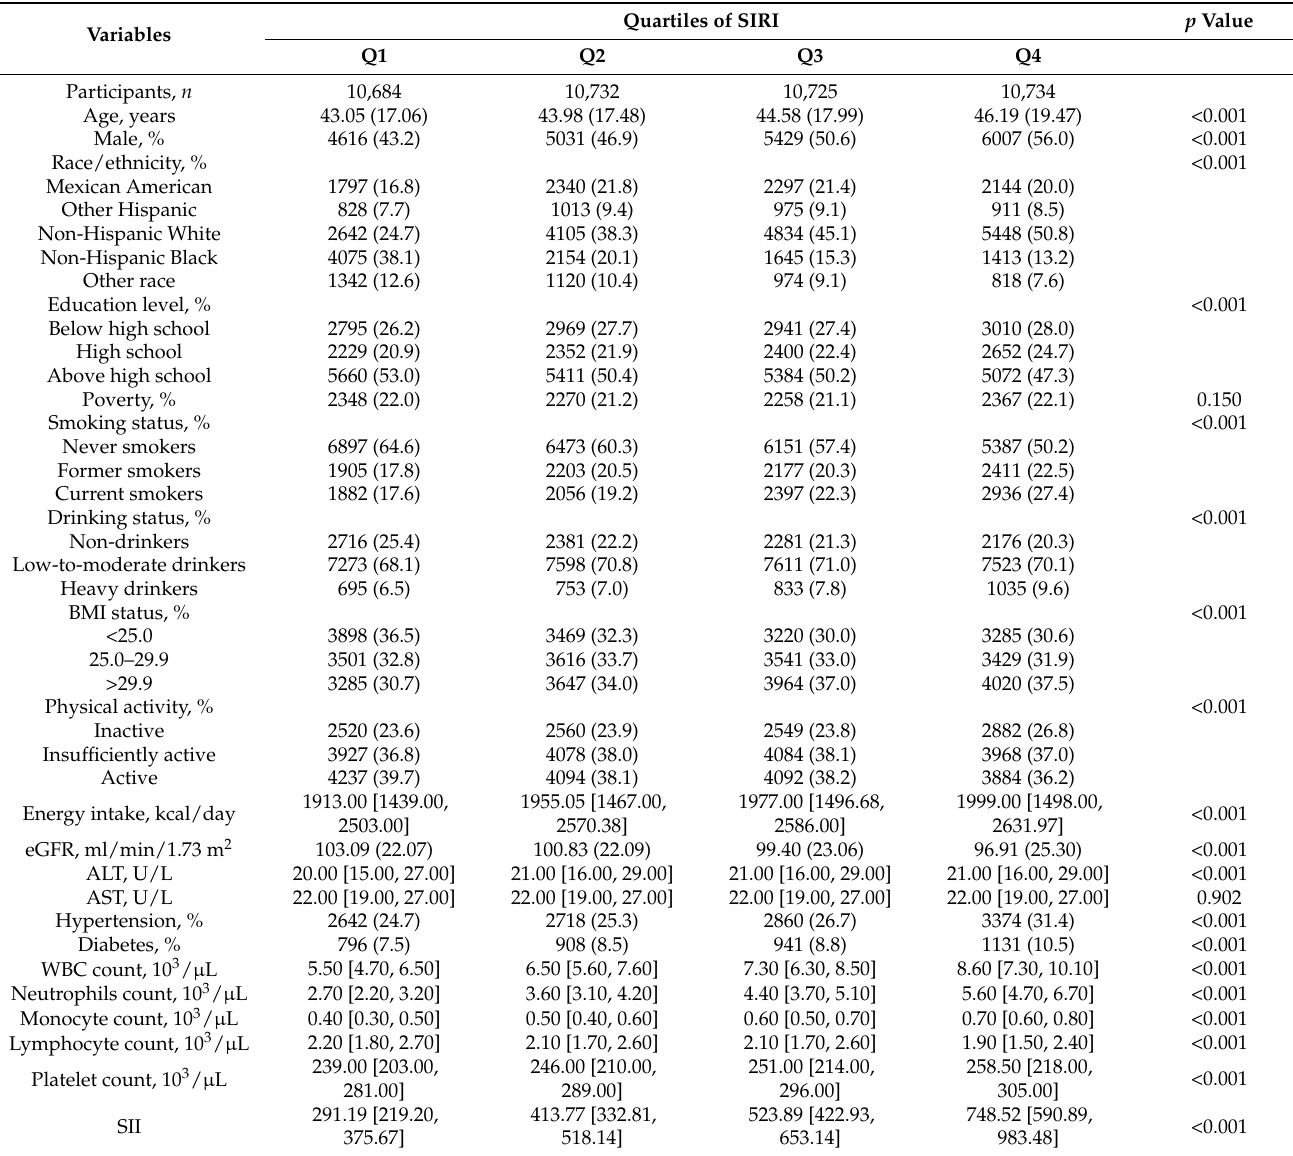
Table 2. Baseline characteristics of quantiles of SIRI among the general adult population in NHANES,